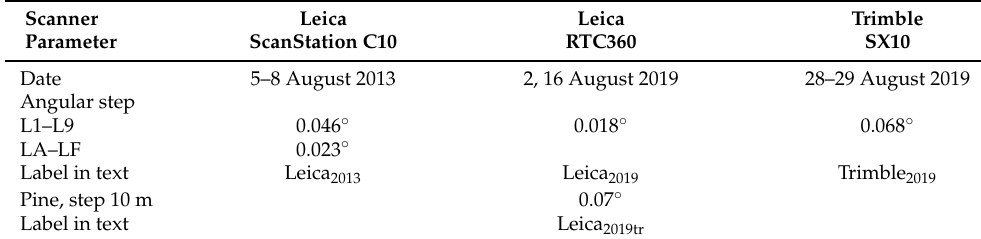
Table 3. TLS measurements.